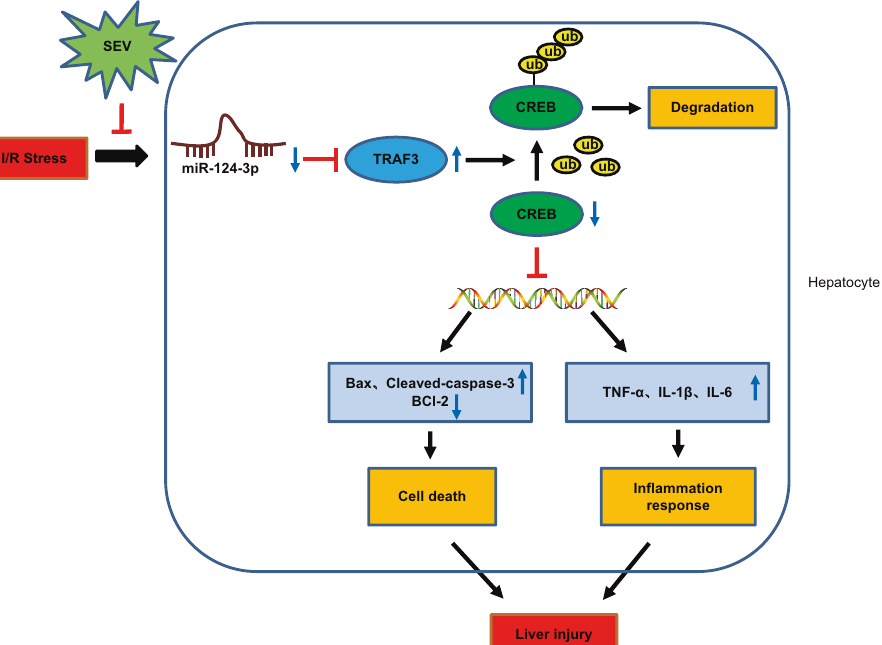
Fig. 7 The proposed regulatory mechanism illustrating the role of miR-124-3p, TRAF3, and CREB in hepatic I/R injury. The expression of miR-124-3p was downregulated when hepatic I/R occurs, which resulted in increased expression of TRAF3 targeted by miR-124-3p, promoting the ubiquitination and degradation of CREB. Upregulation of Bax, cleaved-caspase-3, TNF- α , IL-1 β and IL-6 expression, as well as promoted hepatocyte apoptosis and in fl ammatory response further contributes to hepatic I/R injury. SEV promotes the expression of miR-124-3p and resulted in ameliorated hepatic I/R